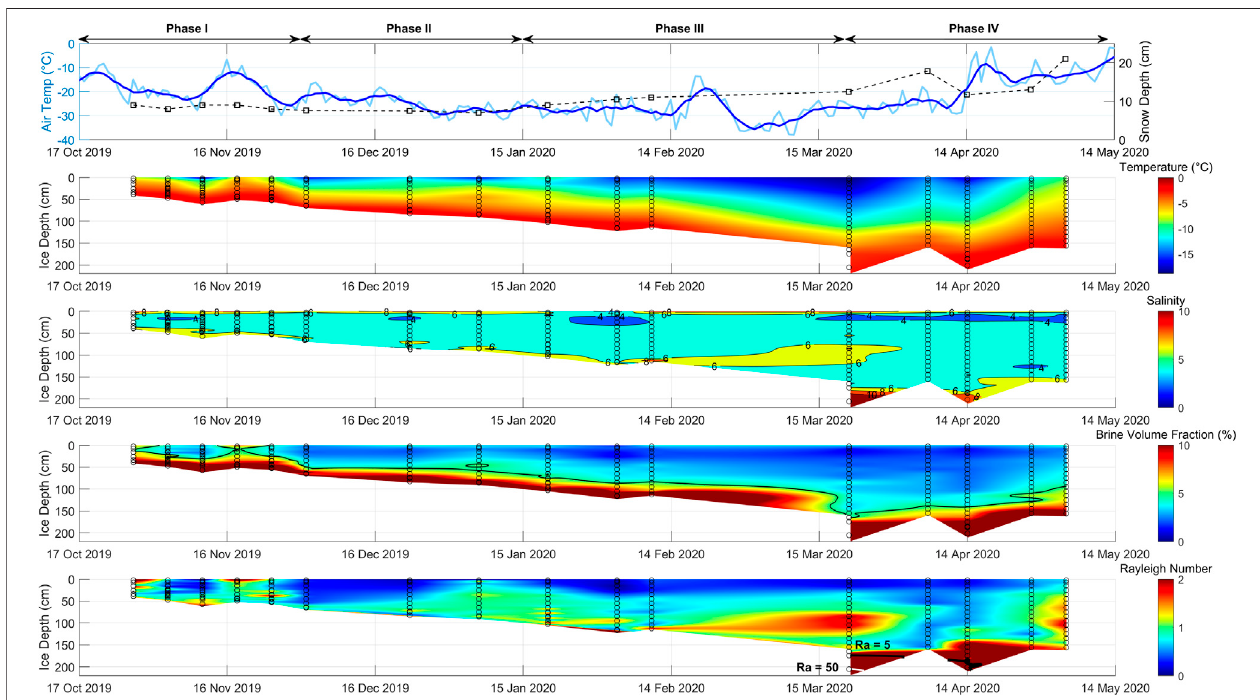
FIGURE4| Theevolutionofphysicalpropertiesatthemaincoring fi rst-yearicesite. See Figure3 captionforadescriptionofcommonlabelsandannotations.The FYI fi eld rafted over a thinner and presumably younger and more saline ice fl oe and such ice cores were extracted on two occasions (21 March and 14 April). The ice thickness trend in spring is affected by both temporal and spatial variability.